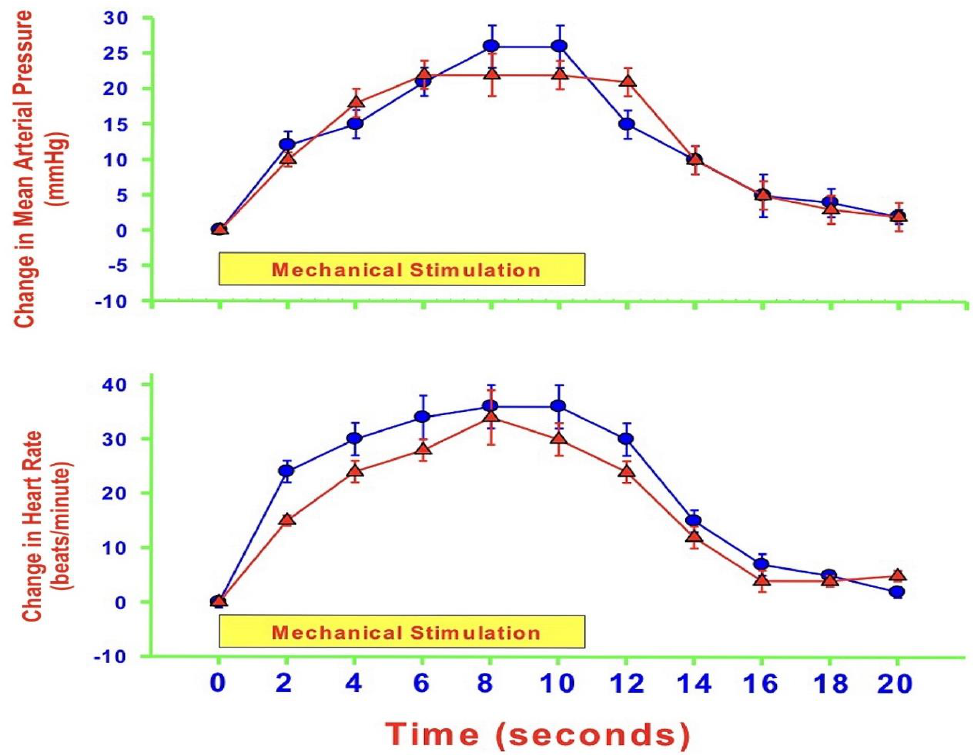
Figure 3. Average time-course changes in mean arterial pressure (MAP: upper panel) and heart rate (HR: lower panel) during 10 s hind paw mechanical stimuli 120 min after bilateral insertion of microdialysis probes into the dorsolateral periaqueductal gray matter (control: blue circles) and 30 min after microdialysis of L-N(5)-(1-iminoethyl) ornithine (L-NIO: 10 µM: red triangles; an endothelial nitric oxide synthase antagonist) into the same area of anesthetized rats. The Y-axes are changes in MAP or HR, and the yellow boxes represent the 10 s time of stimulation. Values represent means ± SEM ( n = 8).